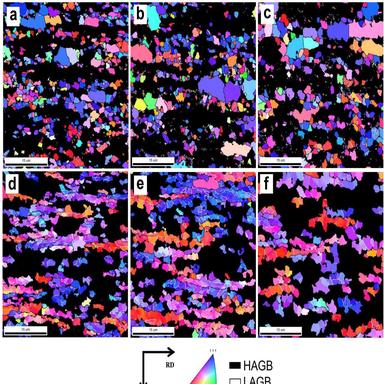
IPF maps after UFH treatment showing the recrystallized (a, b, c) and non-recrystallized (d, e, f) ferrite after 0.2, 1.5 and 30 s, respectively. HAGBs are shown in black and LAGBs in white.